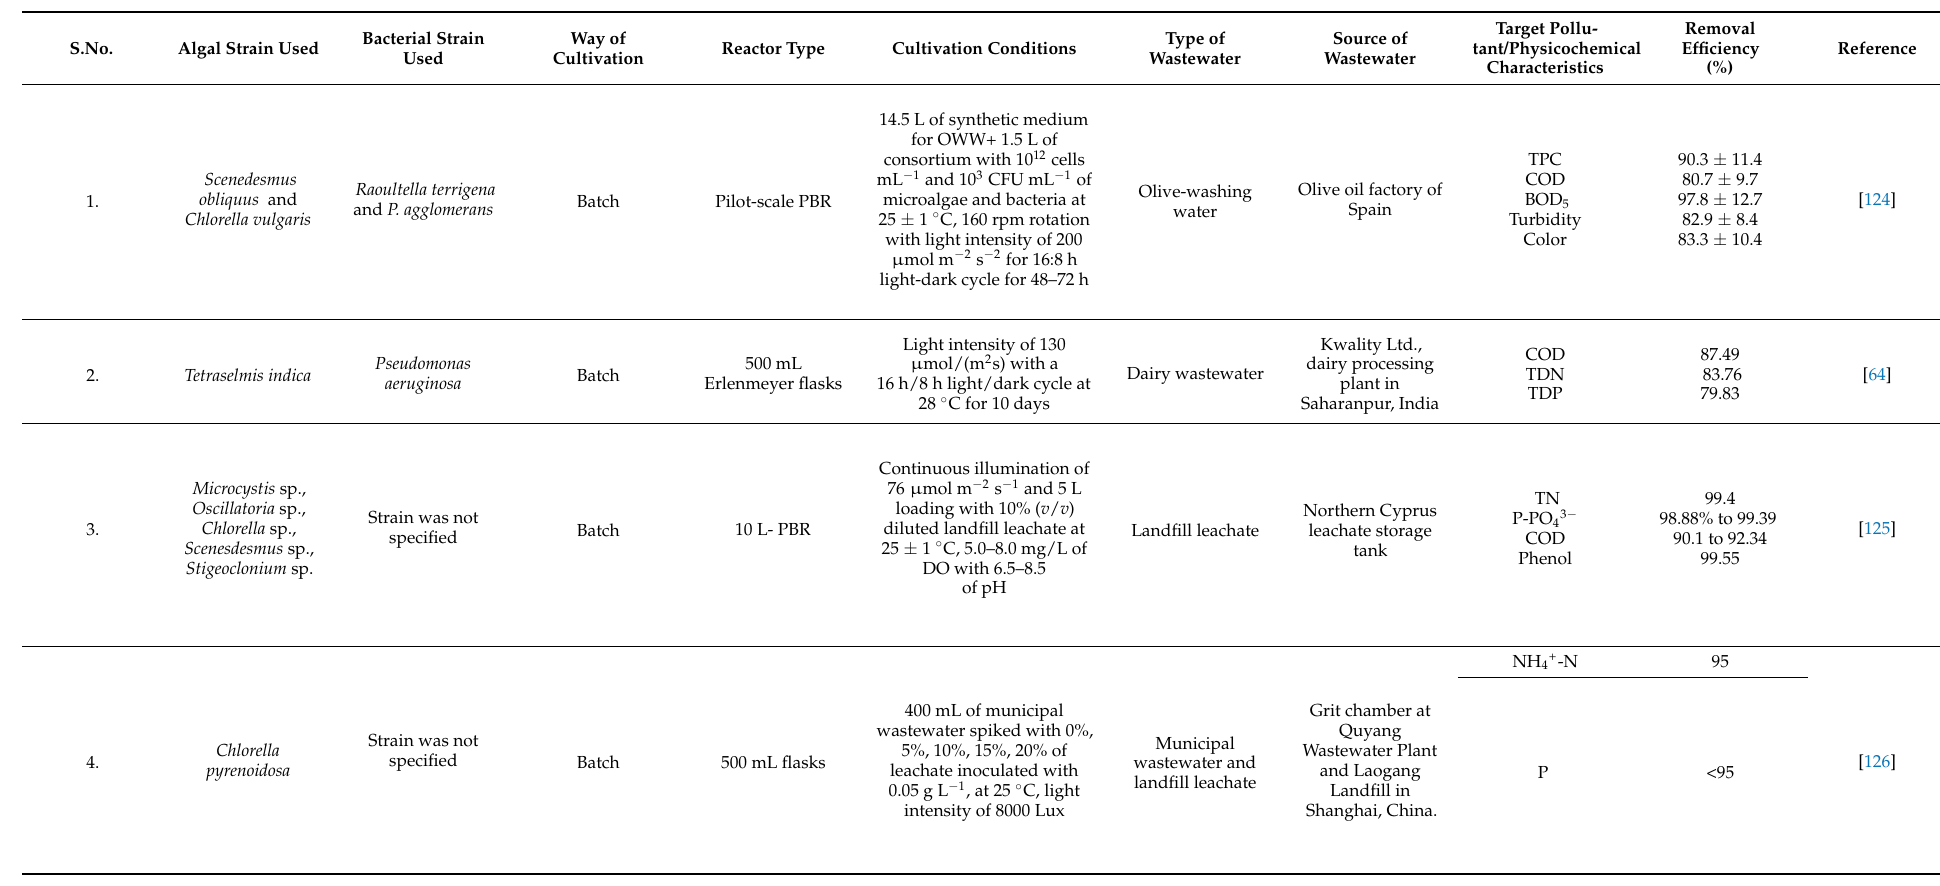
Table 2. Utilization of microalgae–bacterial consortium for wastewater